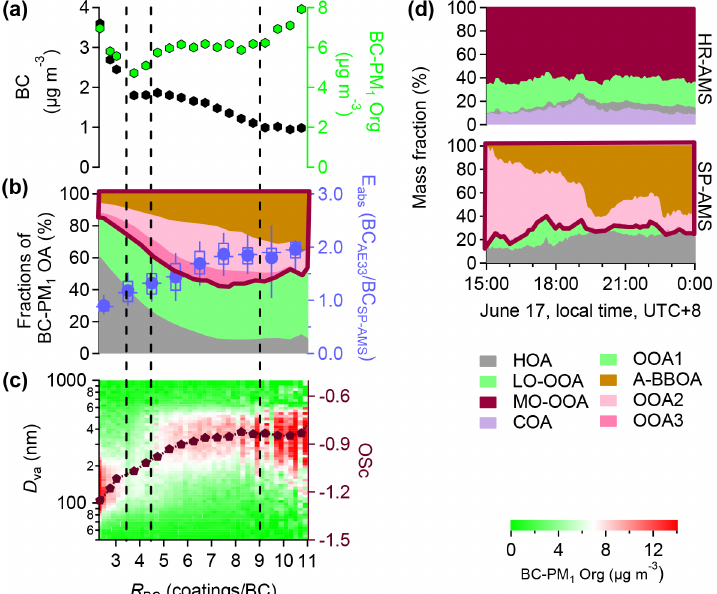
Figure 6. (a–c) The mass loadings of BC and BC − PM 1 Org, the fractions of BC − PM 1 OA factors, E abs , the oxidation state (OSc = 2 × ( O / C ) − (H / C)) of BC − PM 1 Org, and the size distribution of BC − PM 1 Org as a function of coating thickness ( R BC ). (d) Temporal variations of OA fractions of NR − PM 1 and BC − PM 1 from 15:00 to 24:00 on 17 June 2017.